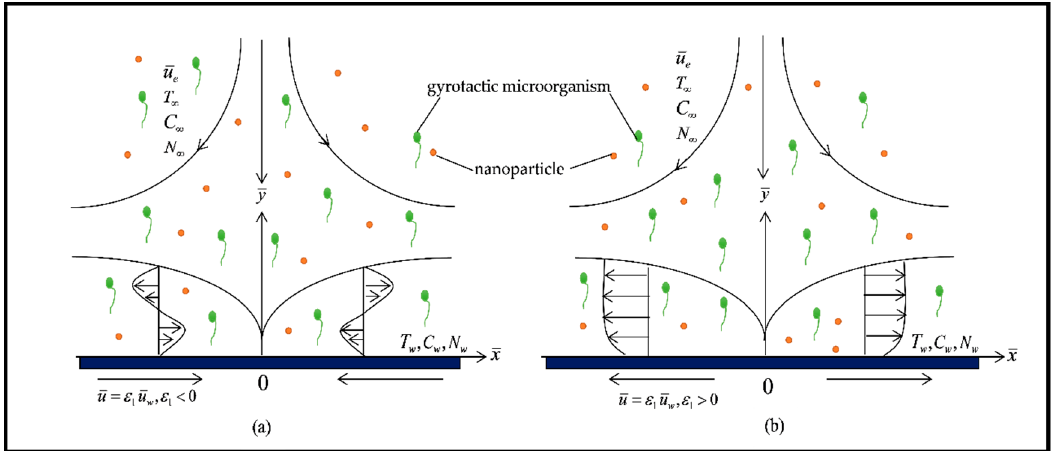
Figure 1. Schematic diagram of the problem. ( a ) Shrinking case. ( b ) Stretching case.